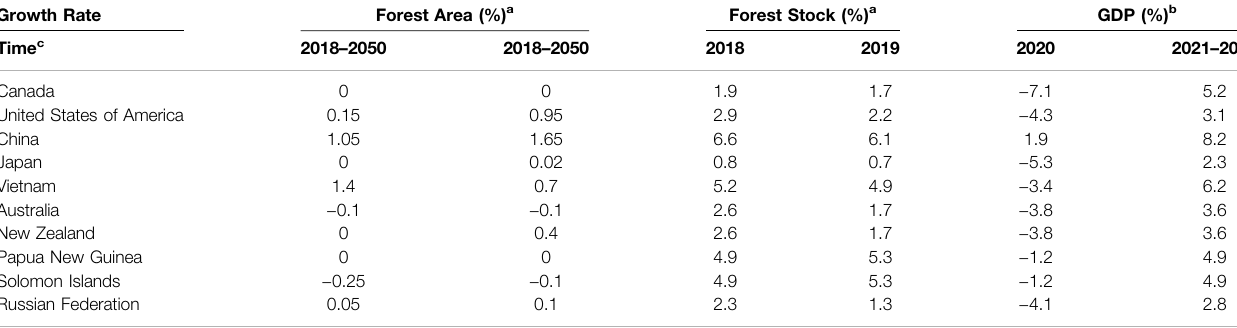
TABLE 2 | GFPM parameter settings of each country under the exogenous assumption of forest resource changes. Growth Rate Forest Area (%) a